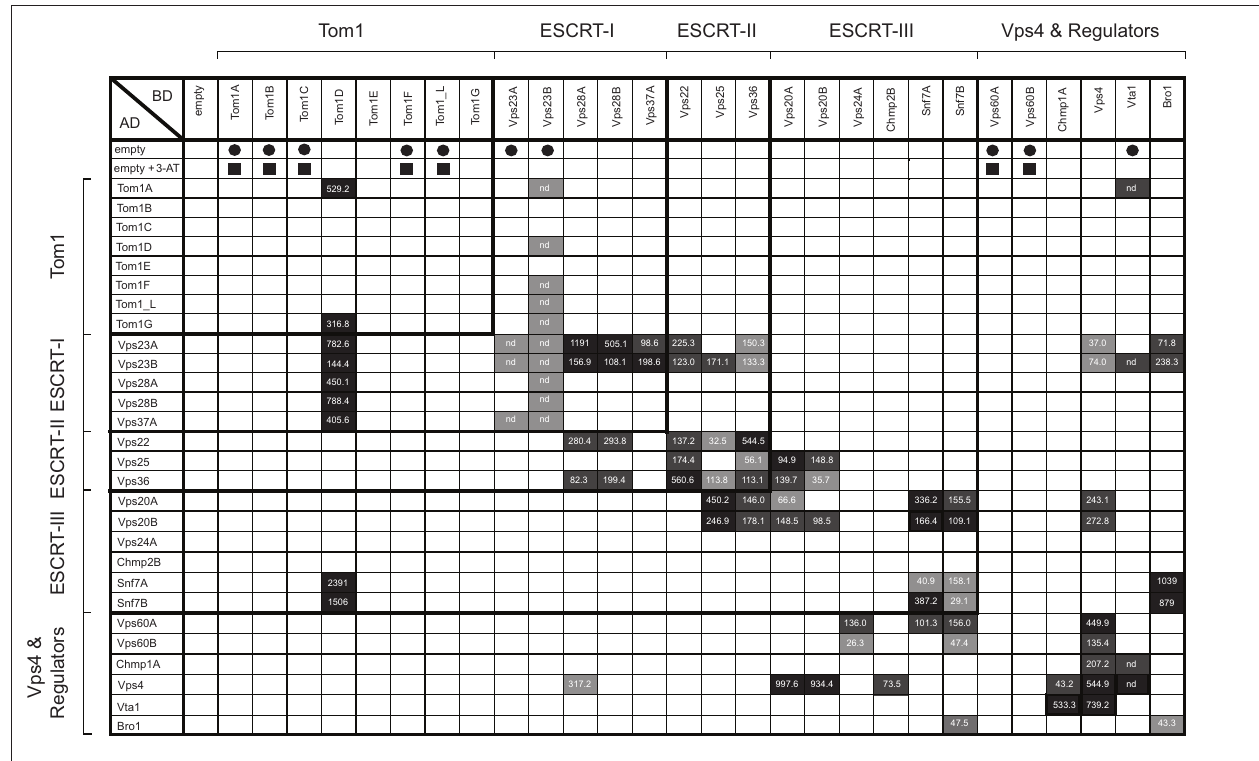
FIGuRE 1 | Matrix illustrating the Arabidopsis ESCRT interactome based on the yeast two-hybrid assay. Plasmids encoding selected GAL4‑AD and ‑BD Arabidopsis ESCRT fusion proteins (as well as the corresponding “empty” AD and BD plasmids) were co‑transformed into yeast, then replica plated on either low‑ or high‑stringency selection media with or without 3‑AT. Those BD‑ESCRT fusion constructs that were not further tested in yeast two‑hybrid (growth) assays because they displayed growth when co‑expressed with the “empty” AD plasmid (i.e., autoactivation) on selective media with or without 3‑AT, are indicated with solid squares or circles, respectively. Shaded boxes represent the